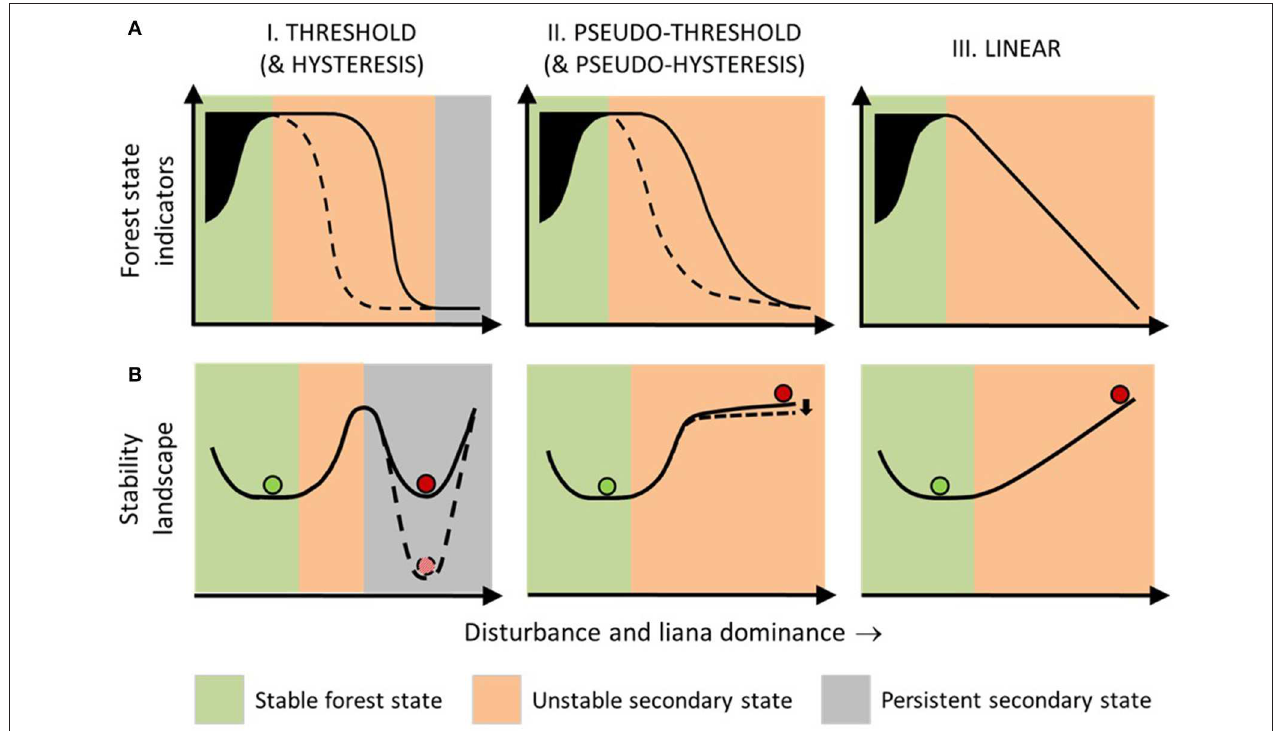
FIGURE 4 | Hypothesised forest recovery response classes following disturbance-induced liana growth (see section above, Five Forest Recovery Response Classes). We visualise forest responses using (A) response curves, based on indicators of forest state, i.e., measurements of forest condition/function, and (B) stability diagrams, showing conceptual variation in “basins of attraction” (see glossary, Table 1 ). Column I (solid lines)—Threshold Response Class: This hypothesises that the forest response after heavy disturbance and under high competitive success of lianas relative to trees (liana dominance) is abrupt and non-linear and gravitates toward a persistent secondary state indicating arrested succession. Column II (solid lines)— Pseudo-threshold Response Class: This hypothesises that the forest response to disturbance and liana dominance follows a smooth non-linear trend and results in an unstable secondary state indicating positive but delayed recovery. Column III—Linear Response Class: This hypothesises that the forest response to disturbance and liana dominance is straight-linear and results in a highly unstable secondary state, indicating steady recovery. Columns I and II also illustrate alternative, more resistant, Hysteretic and Pseudo-hysteretic Response Classes, which hypothesise that the response of forest state indicators during disturbance and increasing liana dominance may follow threshold or pseudo-threshold trajectories, respectively, but after disturbance has ceased (dashed lines) they may follow more resistant response pathways with more persistent secondary states. Green and red balls, respectively indicate the mean expected primary and secondary traits in forest condition/function. Black shading = high variability in primary forest, resulting from natural dynamism (Ghazoul et al., 2015) and forest indicator variation (Gower et al., 1996; Sheil and Burslem, 2003). Figures are developed from established classes of ecological response to environmental change (Andersen et al., 2009; Bestelmeyer et al.,